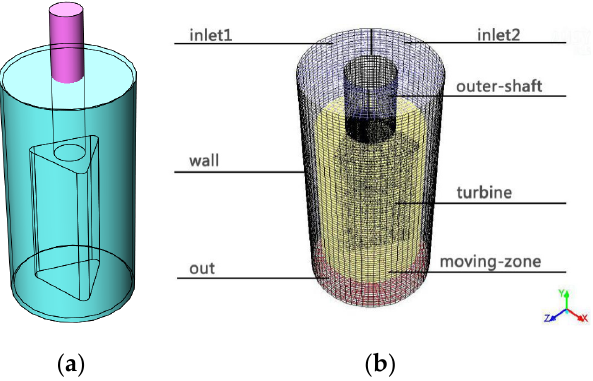
Figure 3. Simplified stirring cavity ( a ) and mesh model for two-fluid stirring ( b ).